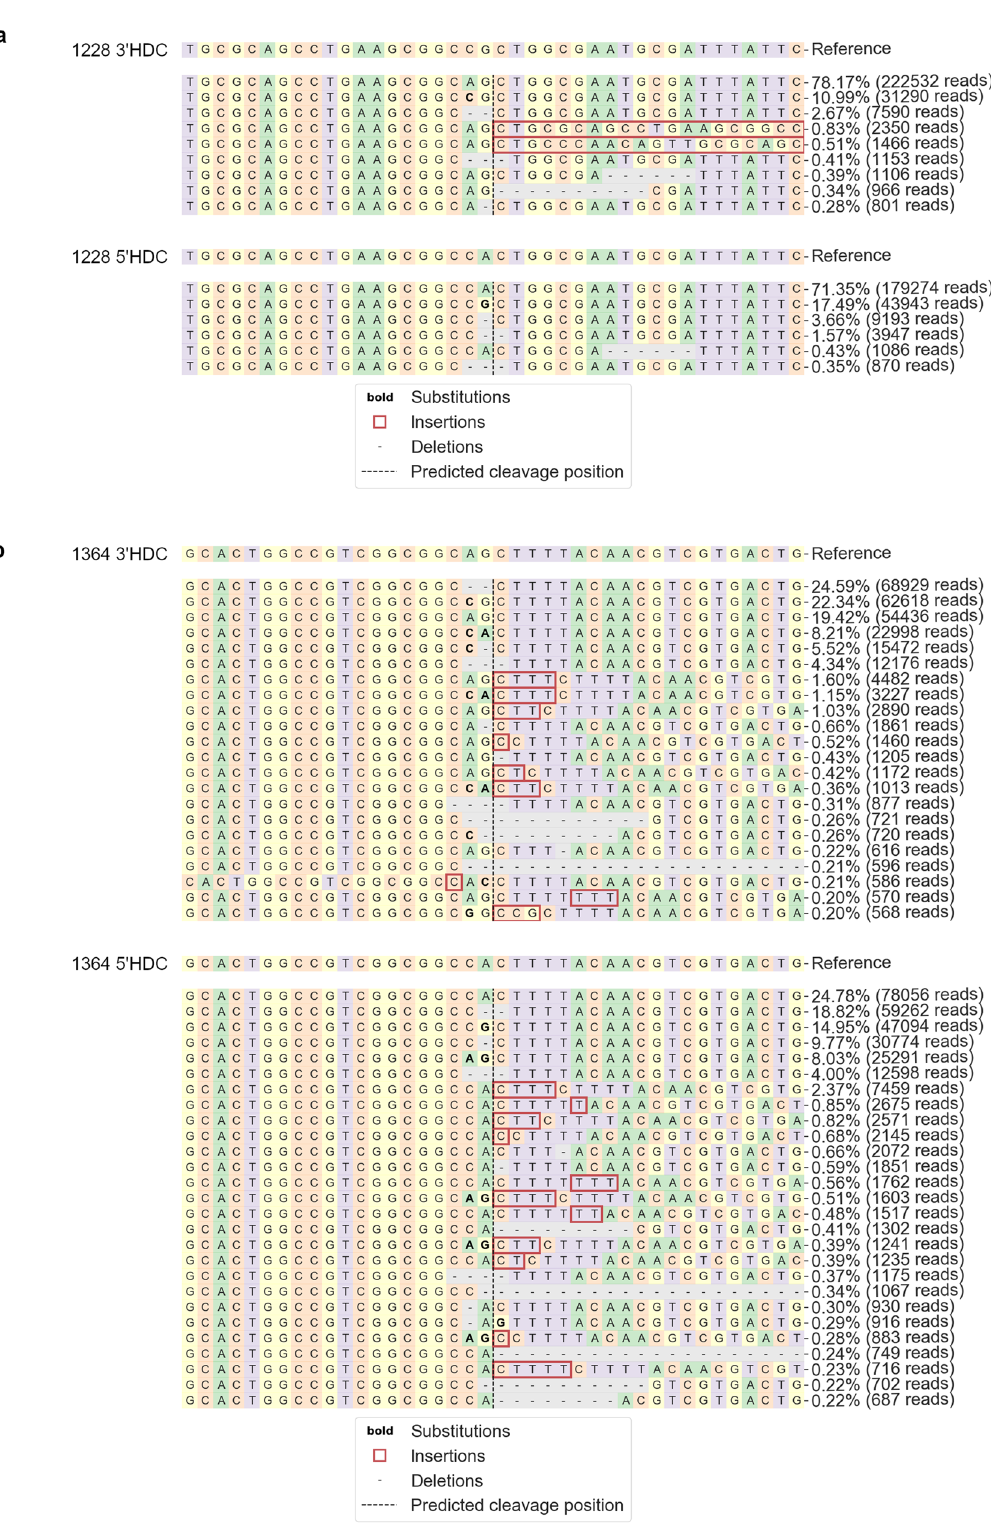
Figure 7. NGS analysis of HDC repair outcomes. DNA recovered after HDC reactions were sequenced via NGS to examine repair profiles of 3 ′ NotI-MT (top) and 5 ′ NotI-MT (bottom) at the ( a ) 1228 and ( b ) 1364 target sites. For each profile, a reference WT sequence of each NotI-MT plasmid is shown in alignment with the individual repair outcomes beneath. The predicted Cas12a cleavage site is shown as a vertical dashed line. The frequency at which each unique indel event was detected is shown to the right as a percentage of the total reads for each NGS reaction. Modifications are shown in bold, insertions within red boxes and deletions with dashed horizontal lines. NGS analysis was done using CRISPResso2 (see “Materials and